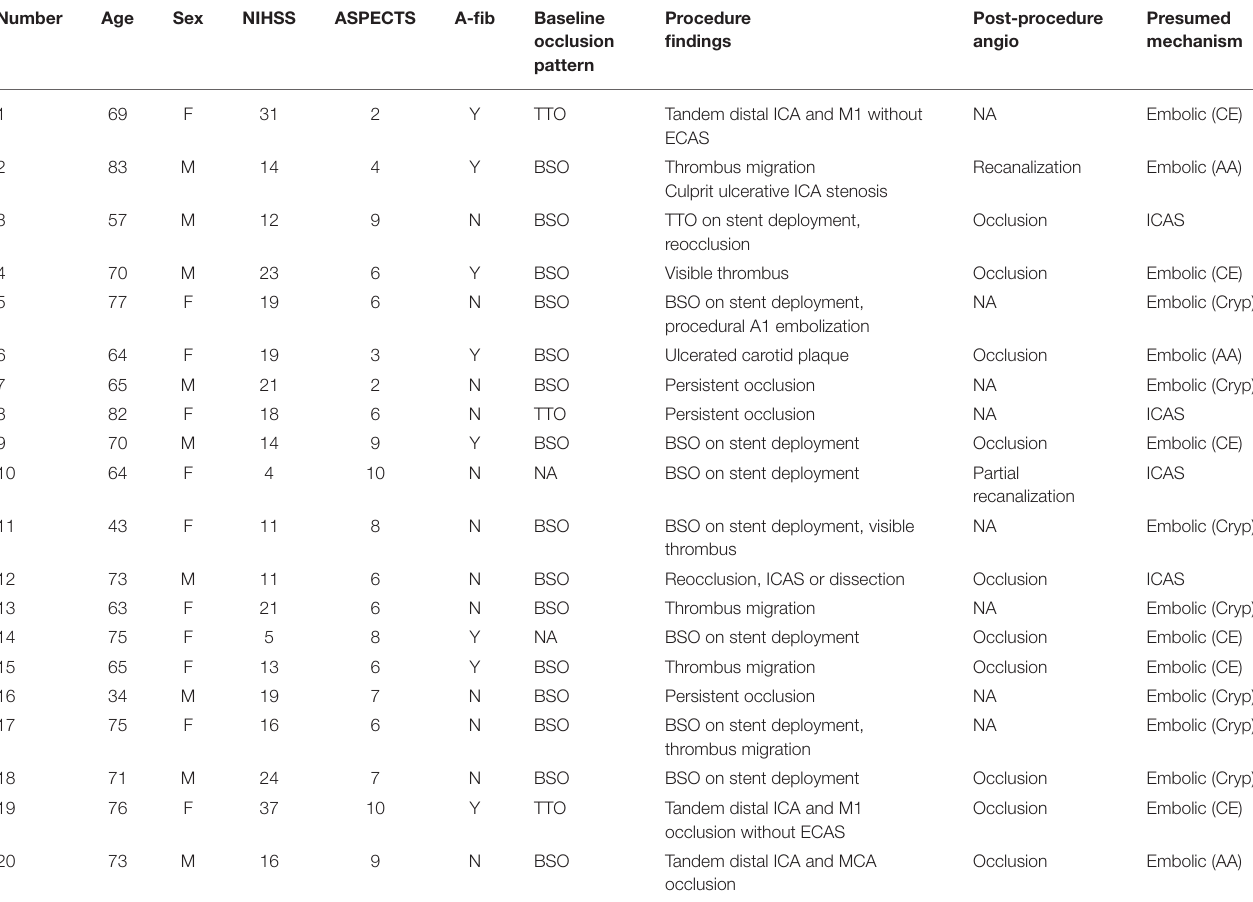
TABLE 4 | Description of the 20 recanalization failure patients according to etiologic classification and expert opinion on presumed etiology. Number Age ASPECTS